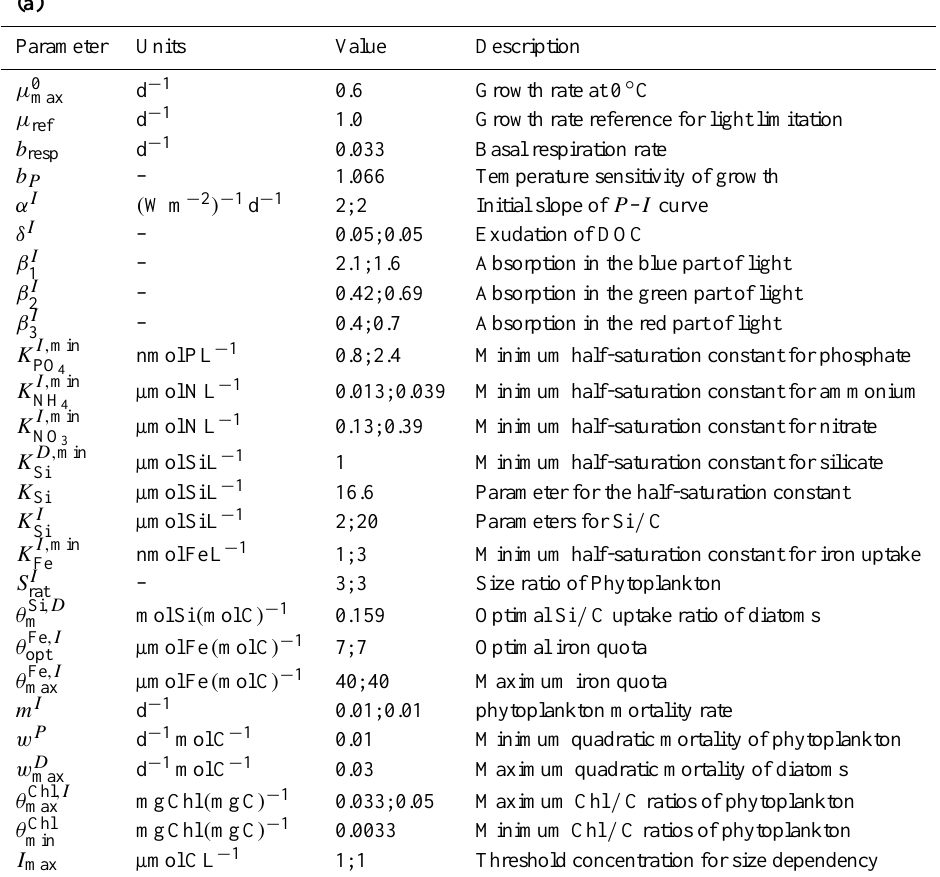
Table 1. (a) Model parameters for phytoplankton with their default values in PISCES. (b) Model parameters for zooplankton with their default values in PISCES. (c) Model parameters for DOM with their default values in PISCES. (d) Model parameters for particulate organic and inorganic matter with their default values in PISCES. (e) Model parameters for various processes with their default values in